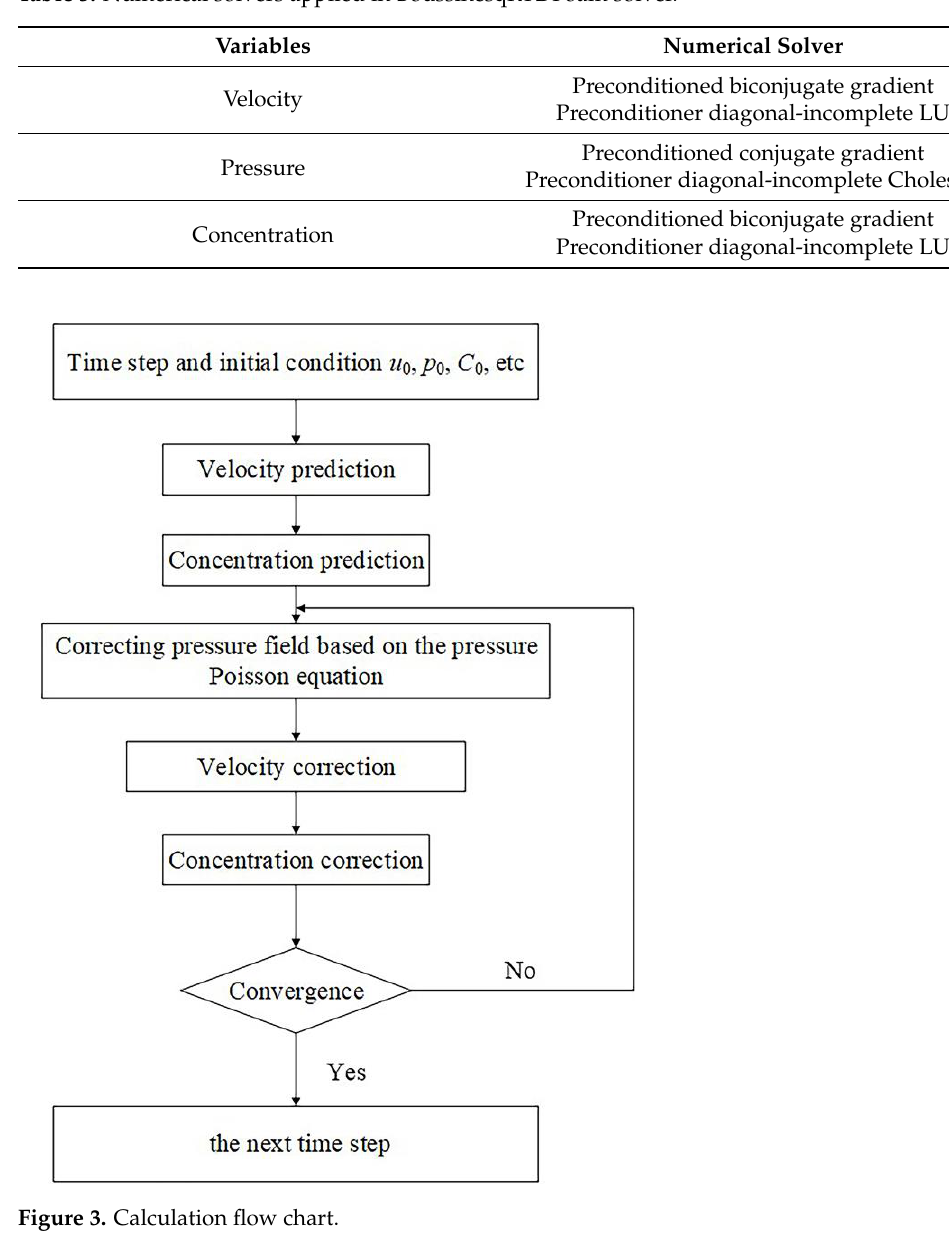
Table 3. Numerical solvers applied in BoussinesqRTDFoam solver.